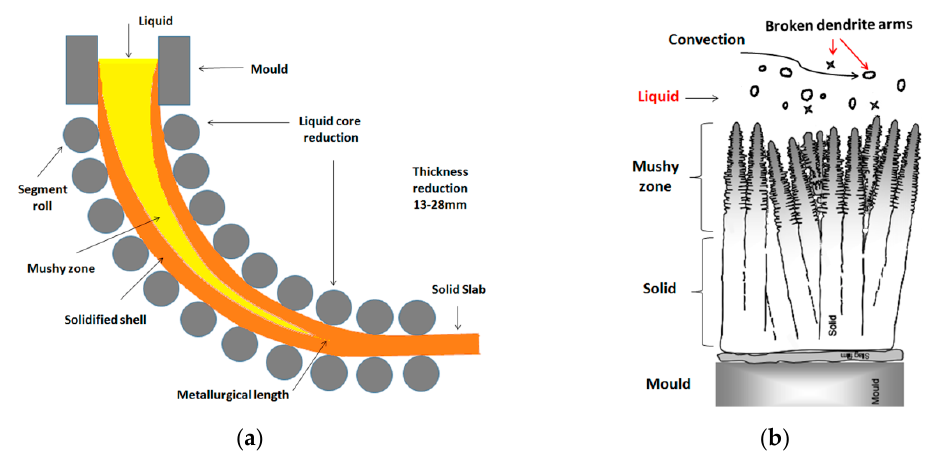
Figure 10. ( a ) Sketch diagram of liquid core reduction during thin-slab cast direct-rolling (TSCDR) process; ( b ) the basic mechanism of grain multiplication or grain refinement from liquid core reduction in the solidification region. The convective movement generates shear, to break the dendrite tips, and circulates the debris in the liquid